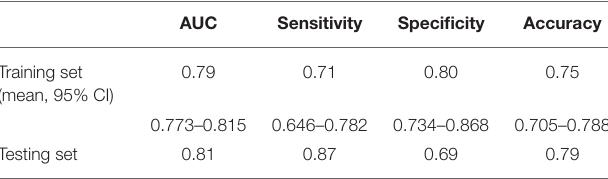
TABLE 2 | The SVM model’s performance in training set and test